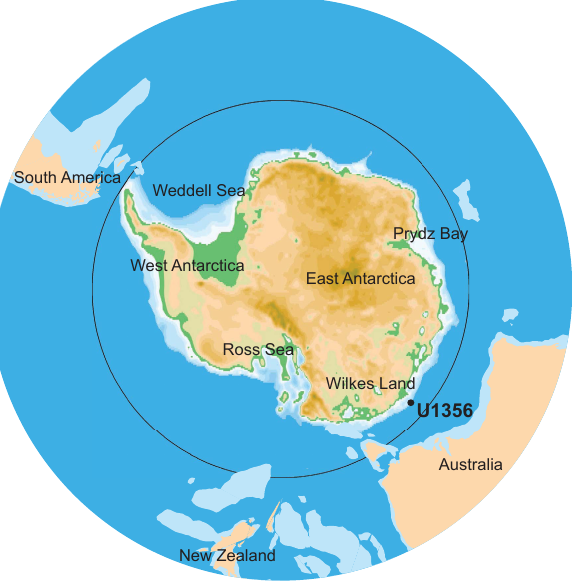
Figure 1. Location of IODP Expedition 318 Site U1356 during the Eocene–Oligocene transition adapted from Houben et al. (2013). Pale blue areas indicate shelf environments and green areas show lowland regions in Antarctica. The black circle is located at 60 ◦ S. Antarctic topography and palaeoceanography modified after Lawver and Gahagan (2003) and Wilson et al.